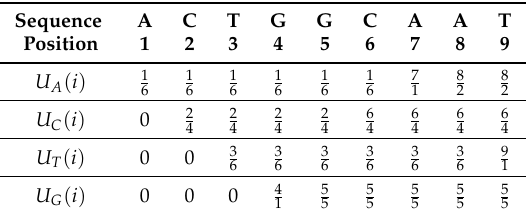
Table 4. The positional distribution of